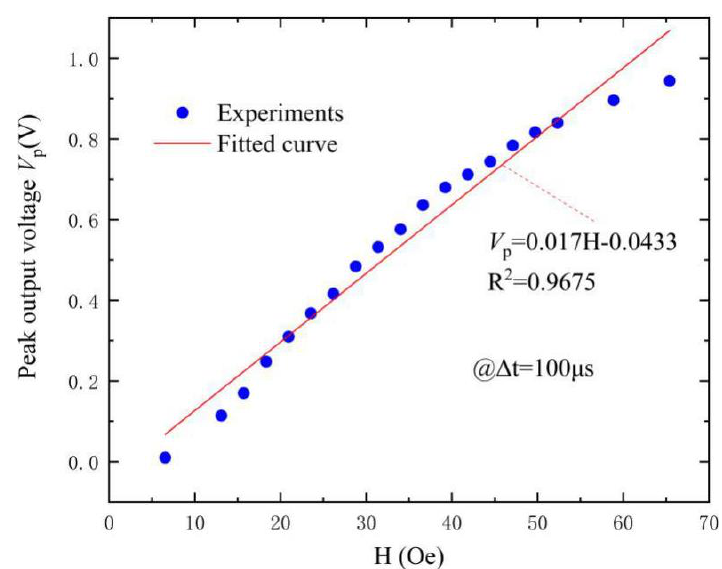
Figure 6. The peak output voltage V p (maximum V o in Figure 3) as a function of the amplitude of the pulsed magnetic field H A for the FeCuNbSiB/piezofiber structure driven by the pulsed magnetic field with Δt = ~100 μs. The red line is the linear approximation.